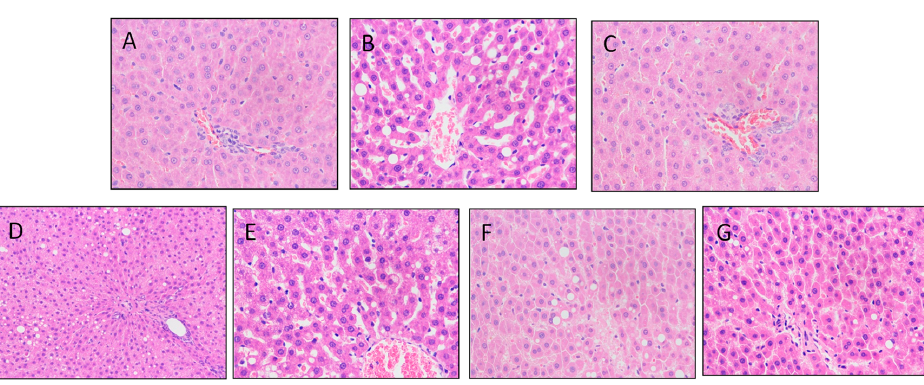
Figure 4. Body weight and index of different groups after gavage. ( A ), Body weight; ( B ), Fat index; ( C ), Lee’s index. *, p < 0.05 compared with the MC group.